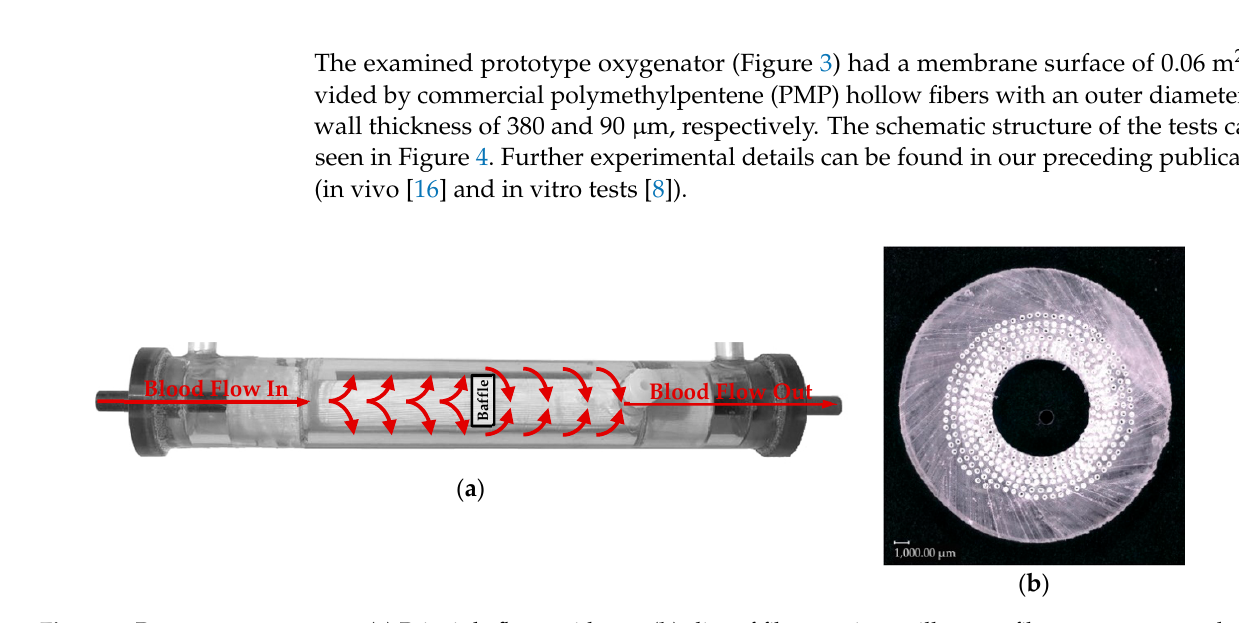
Figure 3. Prototype oxygenator: ( a ) Principle flow guidance; ( b ) slice of fiber potting to illustrate fiber arrangement—by Lukitsch et al. [16] (CC BY 4.0).